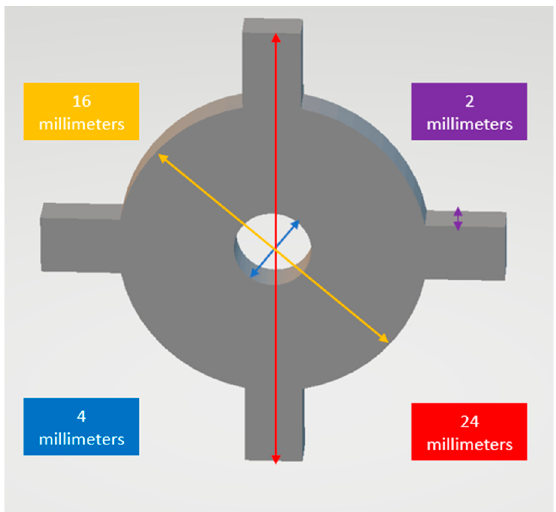
Figure 1. Final digital design of the calibration coupon showing the overall